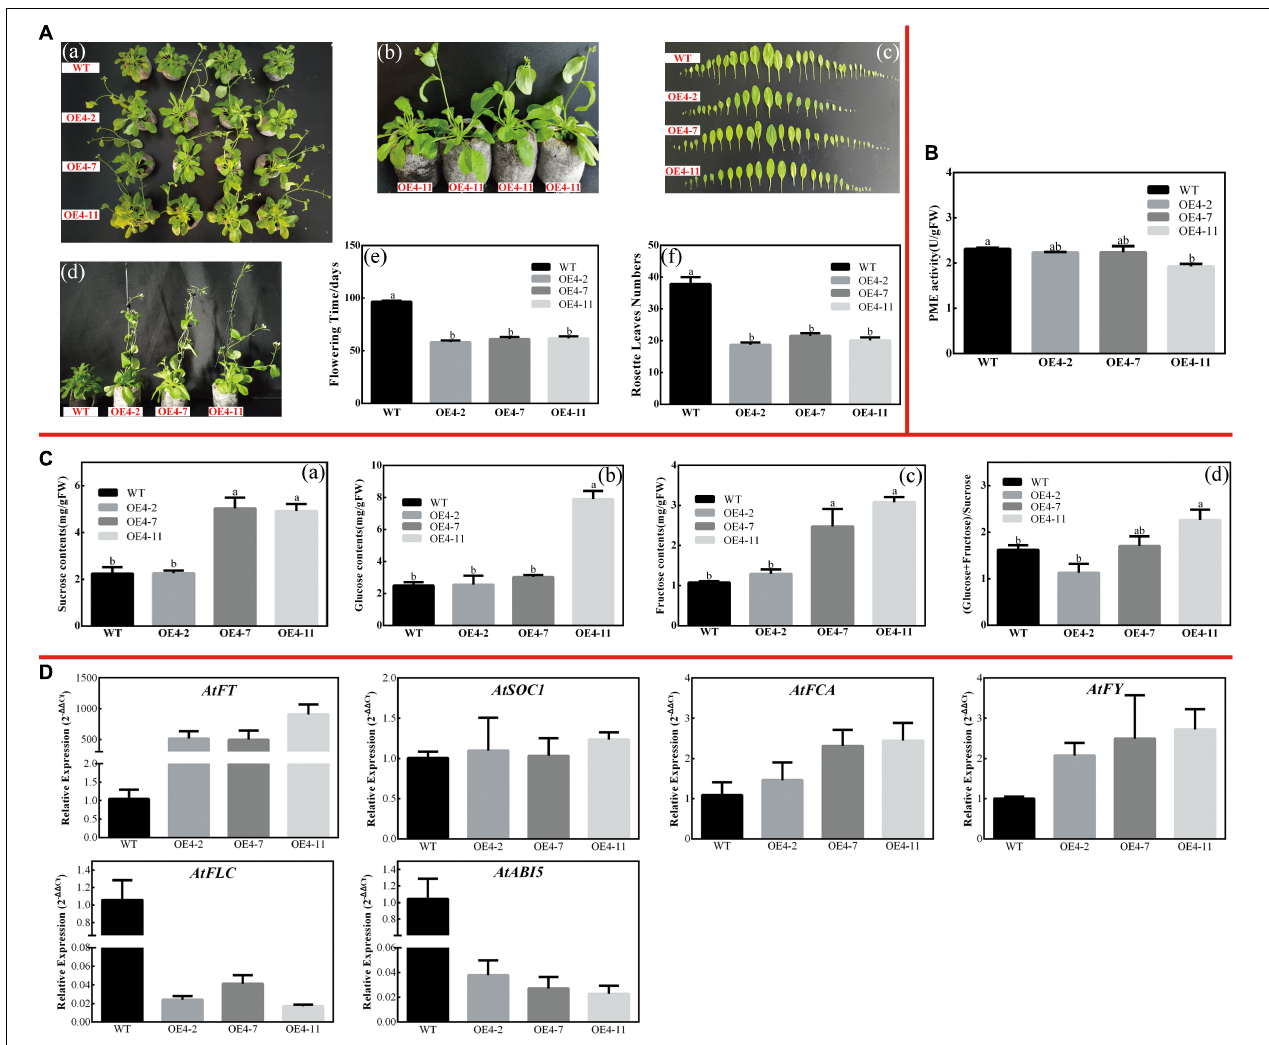
FIGURE 9 | Overexpression of CsPMEI4 promotes early flowering in transgenic Arabidopsis under SD condition. (A) Early flowering phenotypes of CsPMEI4 -OE lines grown under SD condition. (a) Early-flowering phenotype; (b) phenotypes of CsPMEI4 -OE lines and WT plants after 58 d of growth under SD condition; (c) leaf size; (d) phenotypes of CsPMEI4 -OE lines and WT plants after 96 days of growth under SD condition; (e) flowering time; (f) rosette leaves numbers. (B) PME activities of WT and CsPMEI4 -OE lines under SD condition. (C) Sugar contents of WT and CsPMEI4 -OE lines under SD condition. (a) Suc contents; (b)